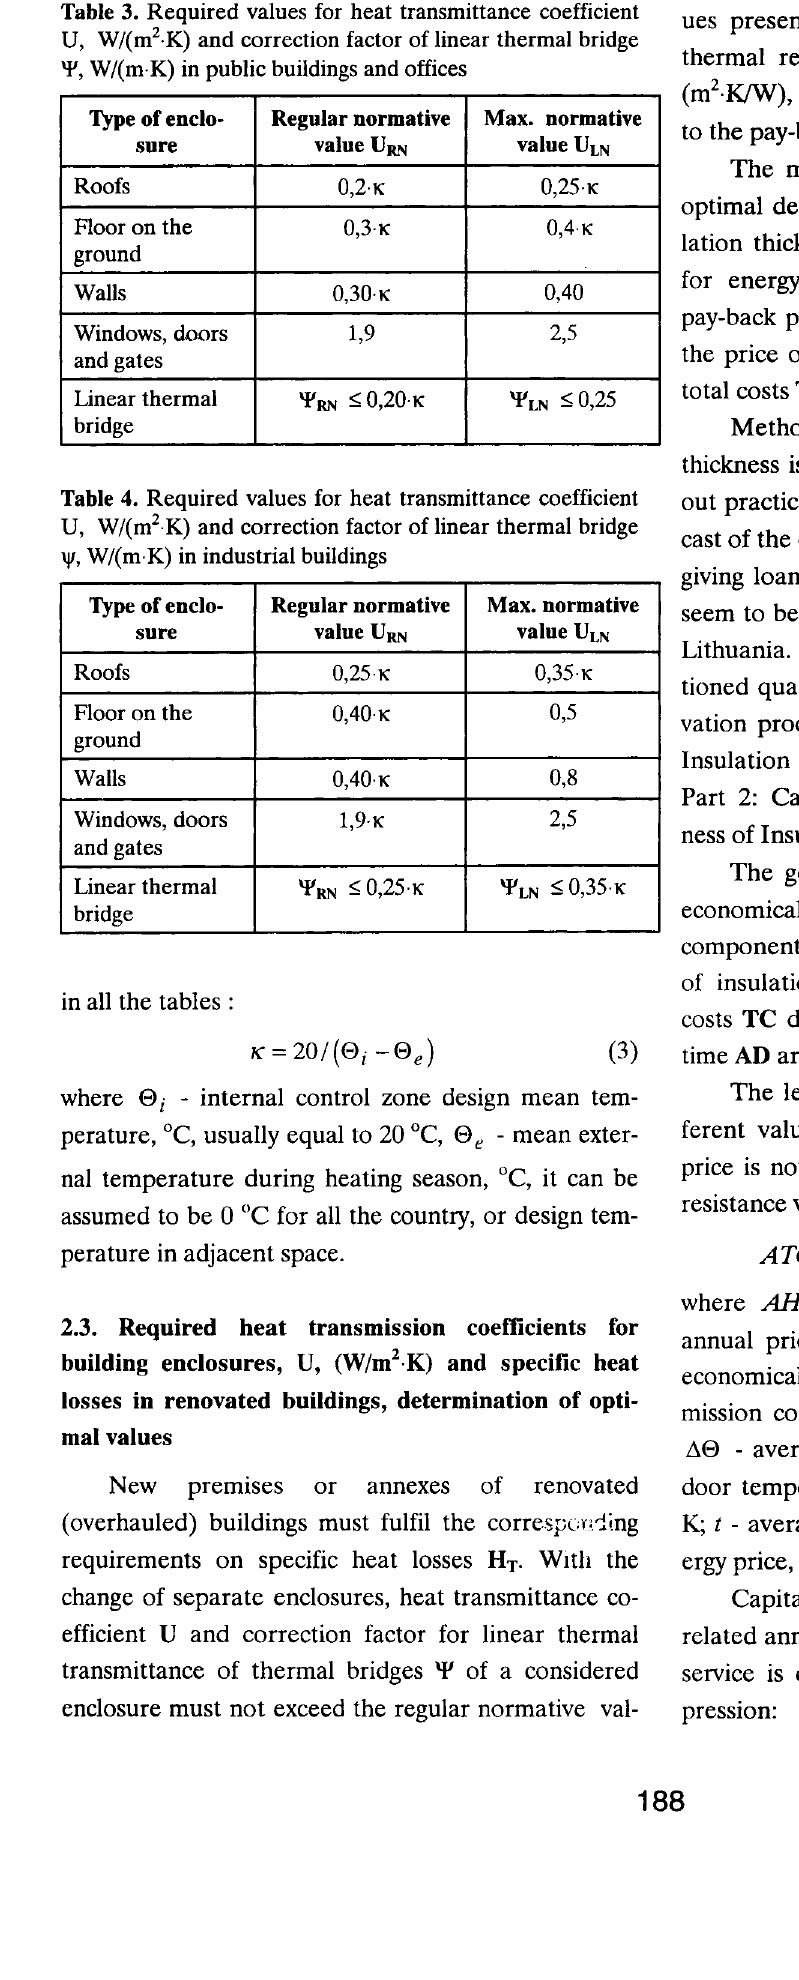
Table 3. Required values for heat transmittance coefficient U, W/(m 2 ·K) and correction factor of linear thermal bridge '¥, W/(m·K) in public buildings and offices Type of enclo-